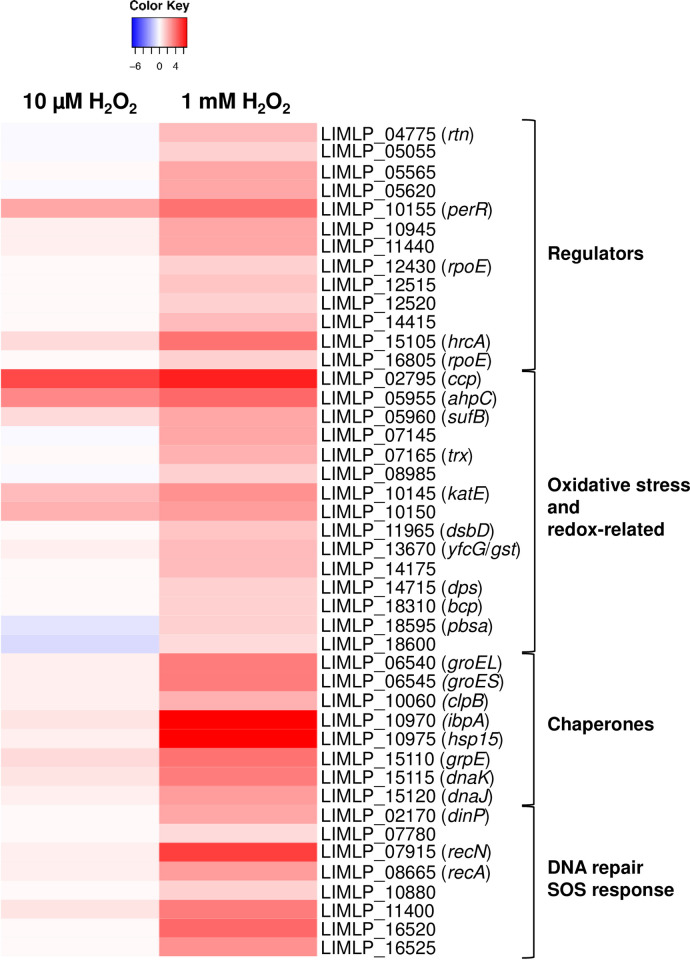
Comparison of up-regulated genes upon exposure to sublethal and lethal doses of hydrogen peroxide.The differential expression of selected up-regulated genes determined by RNA-Seq when L. interrogans are exposed 1 hour to 1 mM H2O2 was compared to that of L. interrogans exposed 30 min to 10 μM H2O2. Differential expression in H2O2-treated Leptospira was obtained by normalization with untreated Leptospira. Genes are organized by their function and their number and name are indicated on the right. The Heat Map color from blue to red indicates low to high Log2FC.